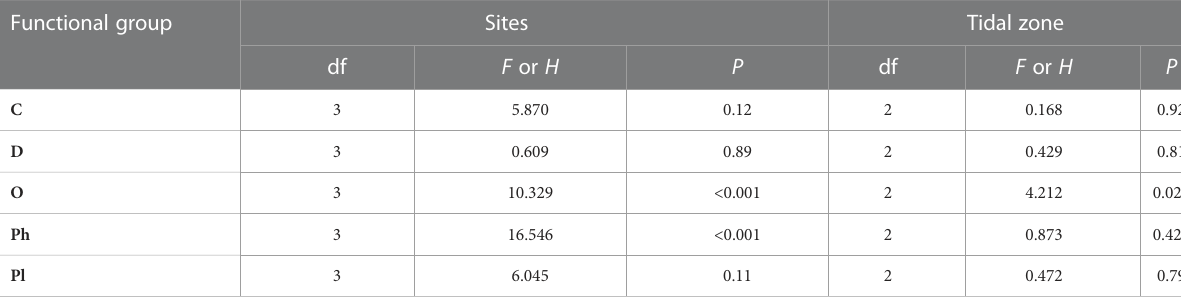
TABLE 2 Study site and tidal zone effects on macrobenthic functional group species richness during 2016-2017. Functional